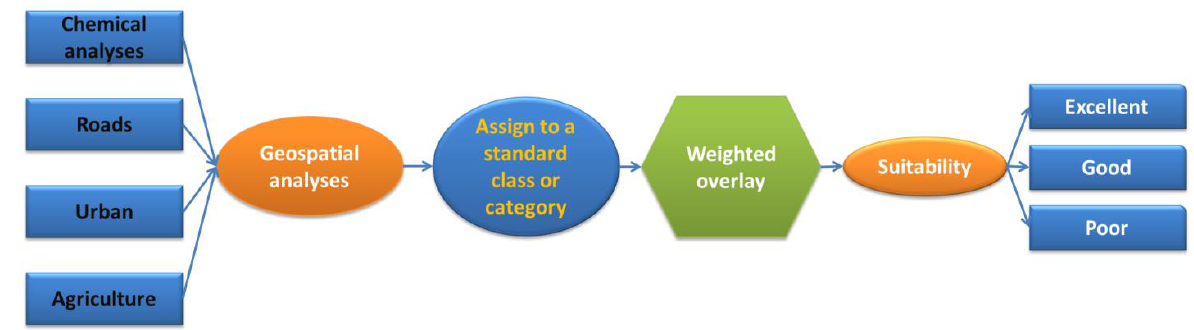
Figure 11. Flow chart of a water quality spatial model for irrigation purposes.